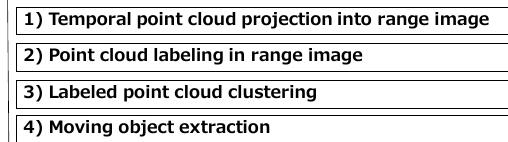
Figure 3. Moving object extraction